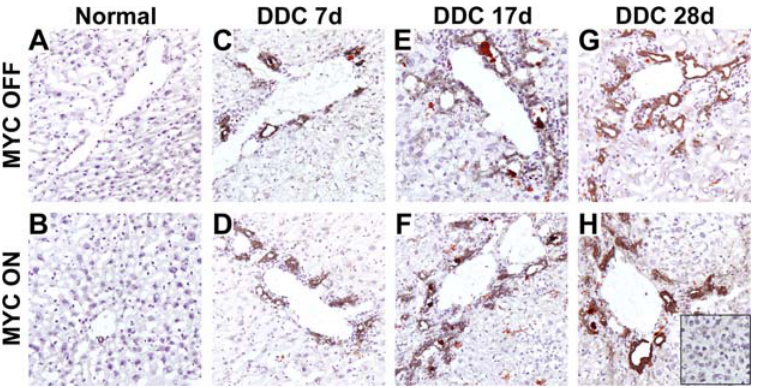
Figure 5. MYC Overexpression Does Not Contribute to Oval Cell Expansion. A6 Immunohistochemistry of: (A) a normal adult liver, (B) an adult liver in which MYC has been activated for 30 days, (C) an adult liver treated with DDC for 7 days, (D) an adult liver that overexpressed MYC in conjunction with DDC treatment for 7 days, (E) an adult liver treated with DDC for 17 days, (F) an adult liver that overexpressed MYC in conjunction with DDC treatment for 17 days, (G) an adult liver treated with DDC for 28 days, and (H) an adult liver with adjacent tumor foci that stemmed from MYC and DDC treatment for 28 days. A6 positive cells are evident in the periportal areas but not in the tumors. Representative data is shown.